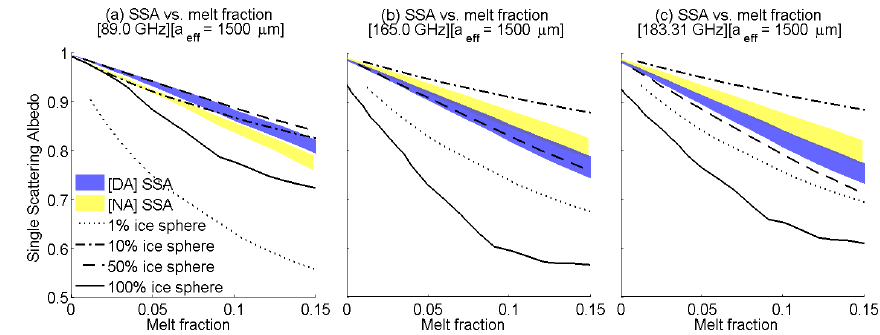
Figure 9. Similar to Fig. 8 except plotting single-scattering albedo ( e ω = Q sca /Q ext ). See text for discussion.